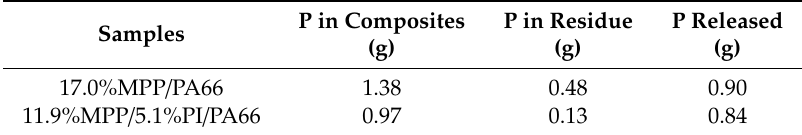
Table 5. The P content data by